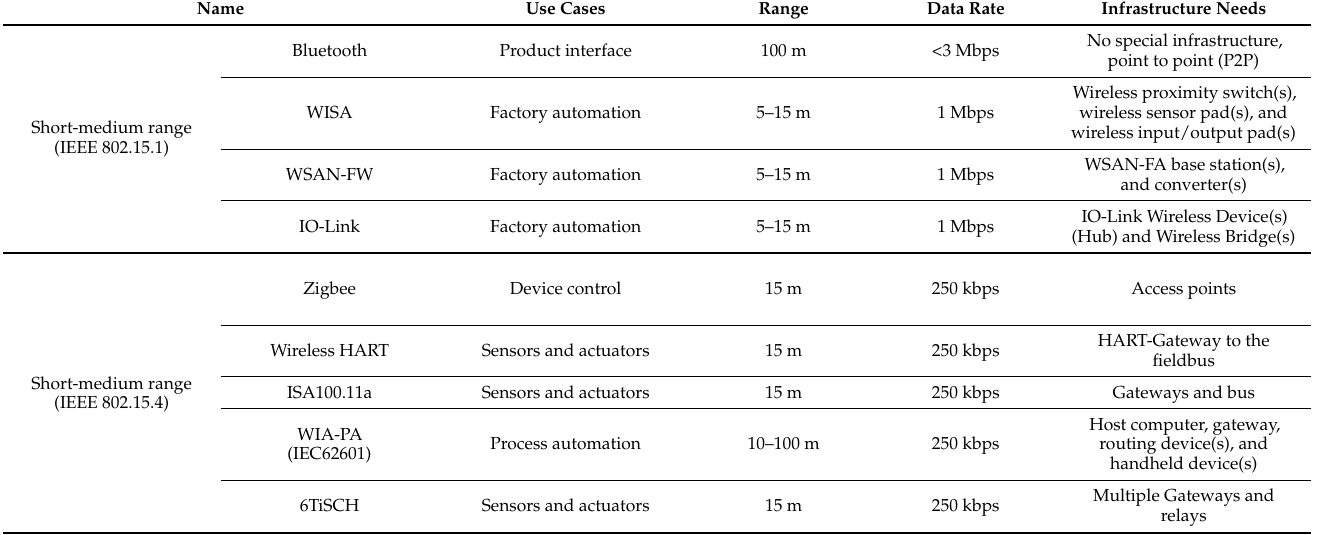
Table 2. Overview of Wireless